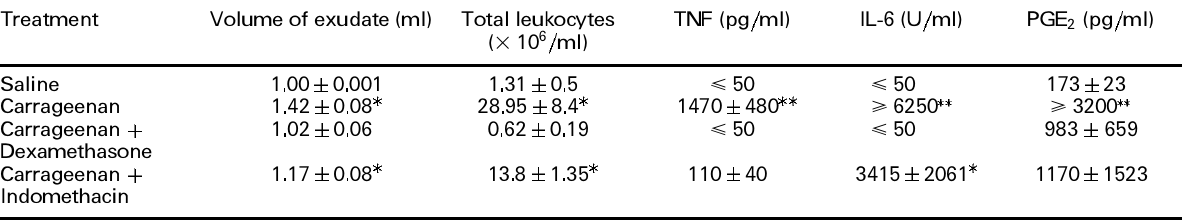
One ml of sterile saline or 1 ml of 1% carrageenan in sterile saline were injected in 6 day-old pouches. 0.2% dexamethasone in drinking water was administered from 12 h before carrageenan. Two doses of indomethacin (2 mg kg) were injected intraperitoneally 30 min before carrageenan and 8 h later. Animals were killed 24 h after the irritant. Data are the mean